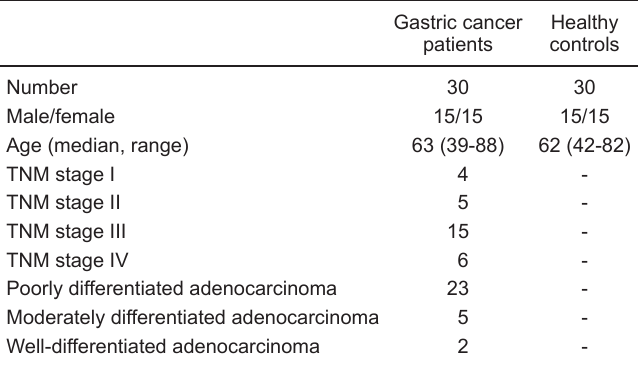
Table 1. Summary of the anatomical and clinicopathological characteris- tics of the gastric cancer patients and healthy controls